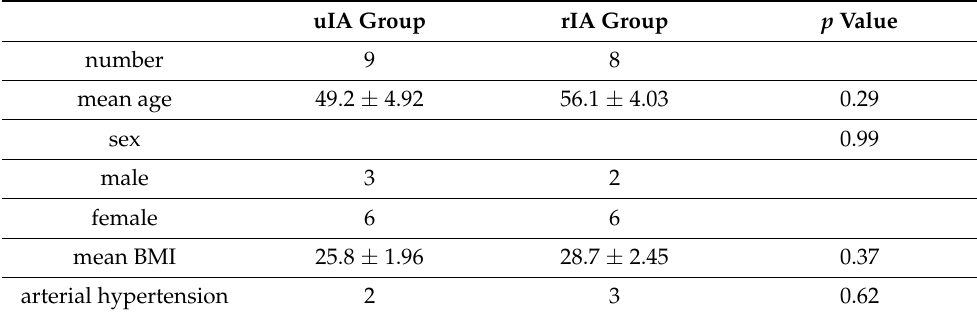
Table 1. Patient